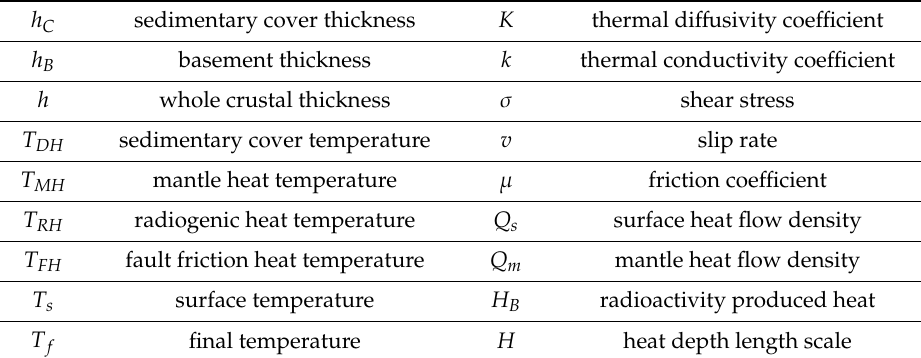
Table 2. Parameters included in the equations adopted in the analytical